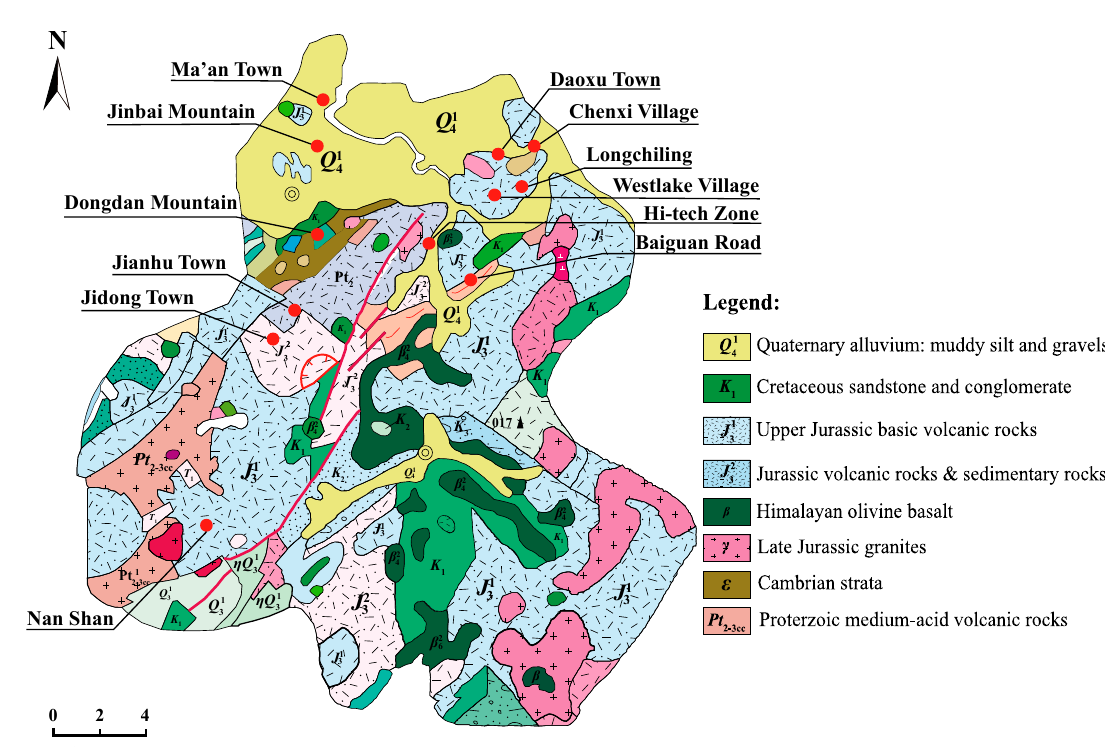
Figure 3. Enlarged view of the geological map of the studied area. (The red points indicate the location of studied slopes.).